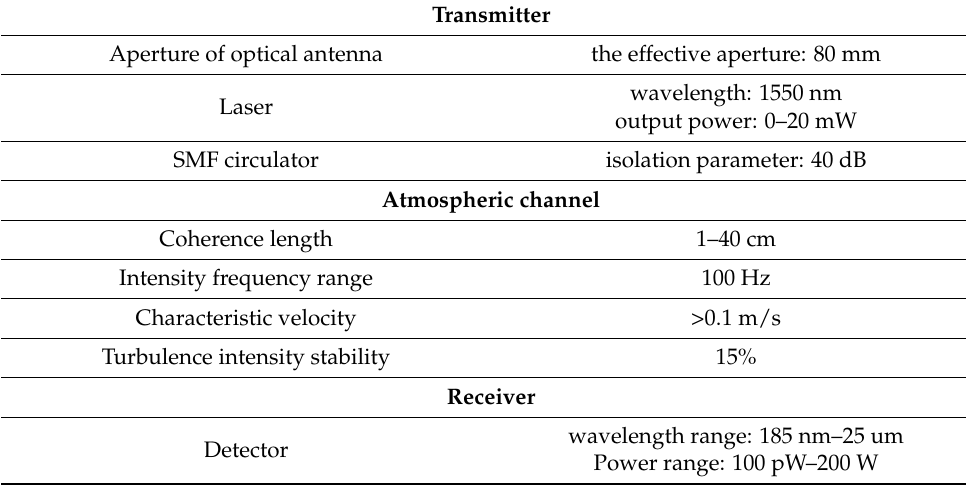
Table 1. Main parameters of the bidirectional coaxial atmospheric laser propagation